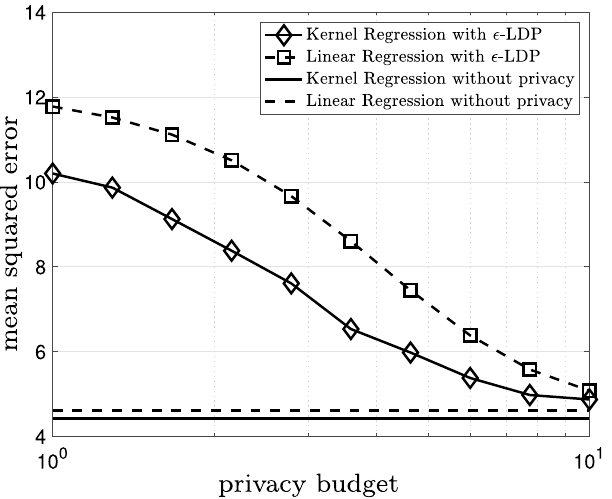
Figure 6. The mean squared error for the kernel regression model and the linear regression model based on the ǫ -locally differential private ( ǫ -LDP in the legend) data versus privacy budget ǫ . The horizontal lines show the mean squared error for the kernel regression model and the linear regression model based on original noiseless data.